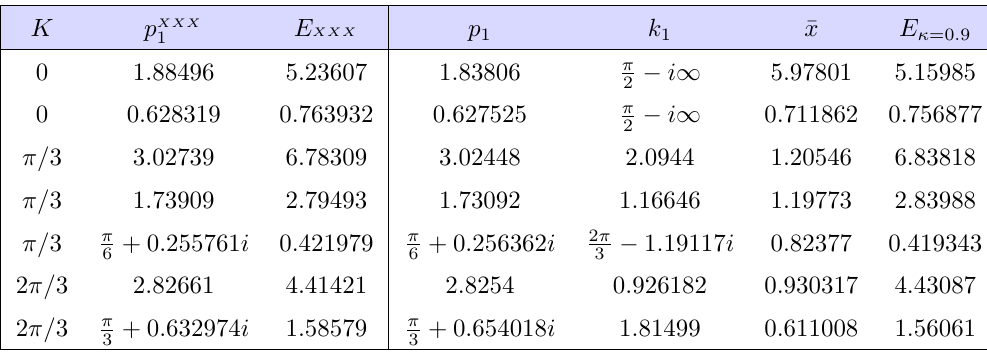
Table 3 . Length-6, κ =0 . 9 twisted XY -sector chain: some momenta appearing in the twisted XY sector 2-magnon problem for the case L = 6 , κ = 0 . 9 . K is the total momentum. For reference, on the left we list the twisted (antiperiodic) XXX momenta and energies. The p found as p = K − p , k = K − k . We have chosen the p momenta for the interpolating theory 2 1 2 1 to be the ones that are closest to the corresponding momenta for twisted XXX . ¯ x is the ratio between the A and B solutions, as discussed in the